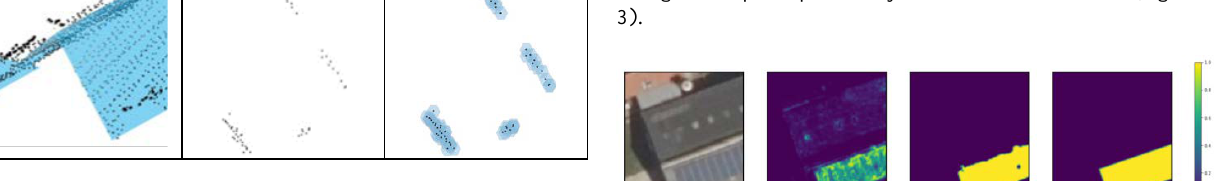
Figure 1 . Obstacle detection based on geometry mismatches between the datasets (left to right: highlight of the most distant points, selection, offset)